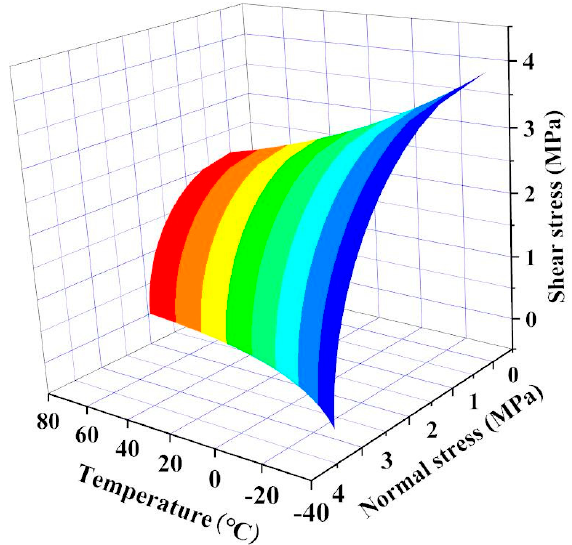
Figure 16. ISR-7008 adhesive joint failure criterion surface.